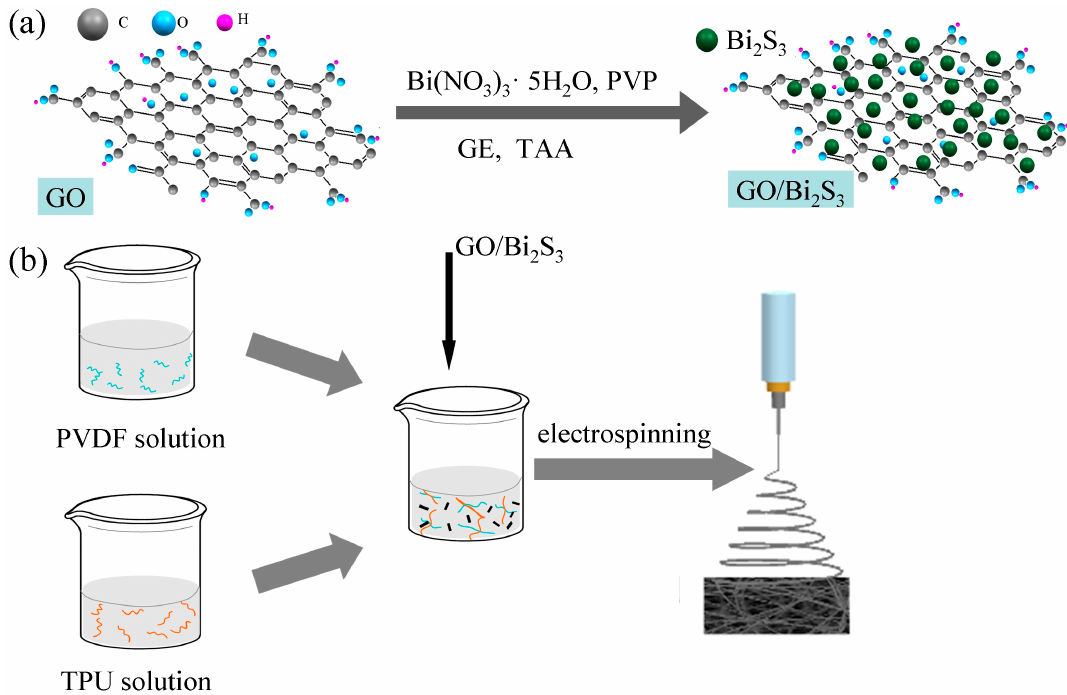
Figure 9. Schematic illustration of the synthesis of GO / Bi 2 S 3 NPs ( a ) and preparation of the GO / Bi 2 S 3 -PVDF / TPU nanofibers membrane ( b ).